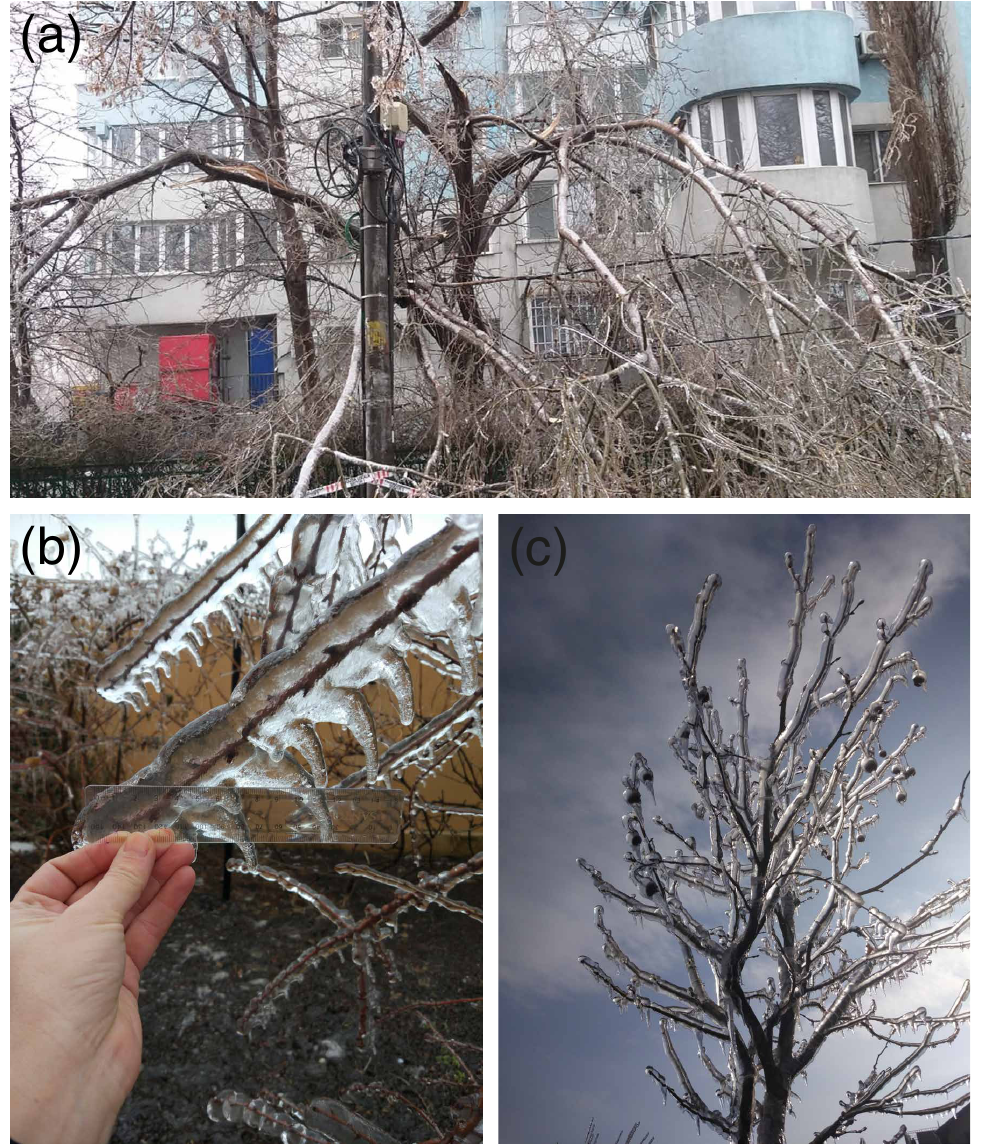
Figure 2. ( a ) Freezing rain impact in Bucharest on 25 January 2019 and ( b , c ) ice accumulation in M˘agurele (southwest of Bucharest). In ( b ) the ice layer on the branches was estimated at 2–4